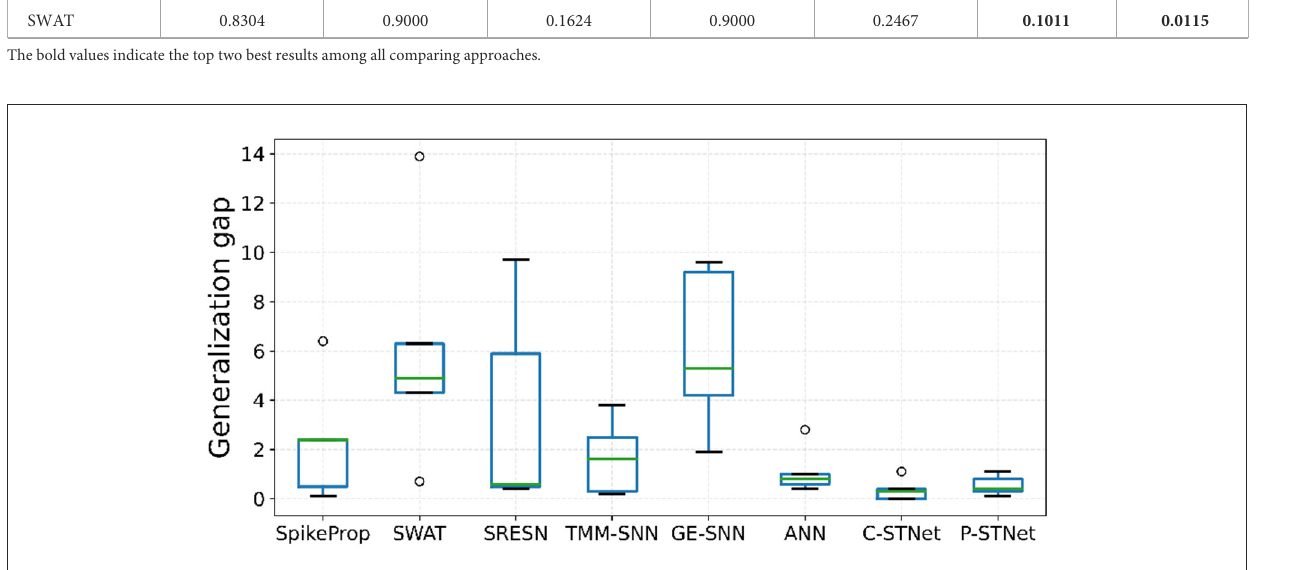
FIGURE6 Boxplots of the generalization gaps on the five small datasets for the eight